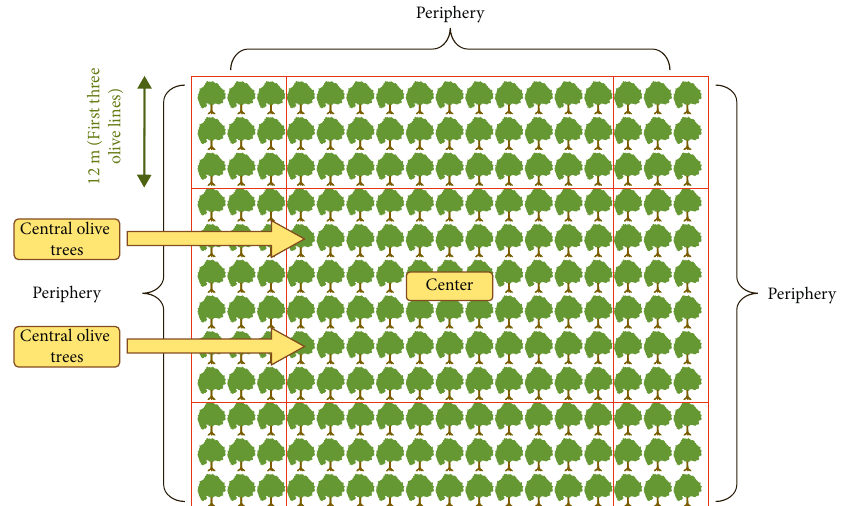
Figure 2: Schematic diagram showing the marginal and central zones of the monitored olive orchards in the Fez agricultural zone.